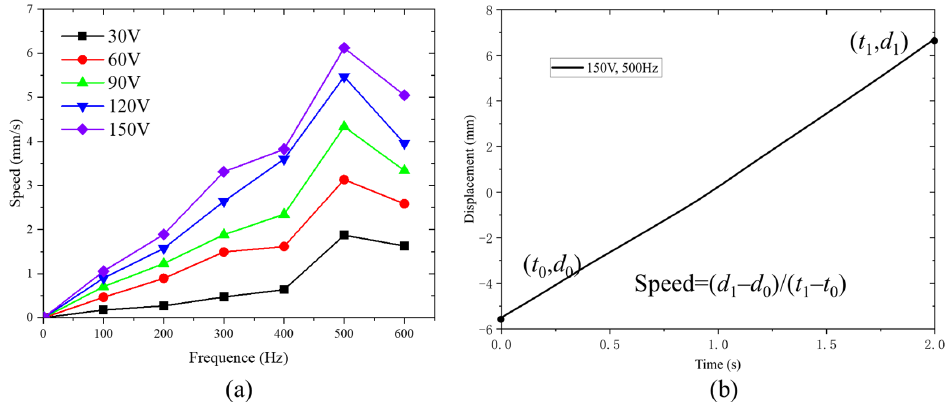
Figure 9. Speed test results of the actuator: ( a ) speed versus frequency under different driving voltage; ( b ) time history of the displacement of driving voltage with 150 V and 500 Hz.